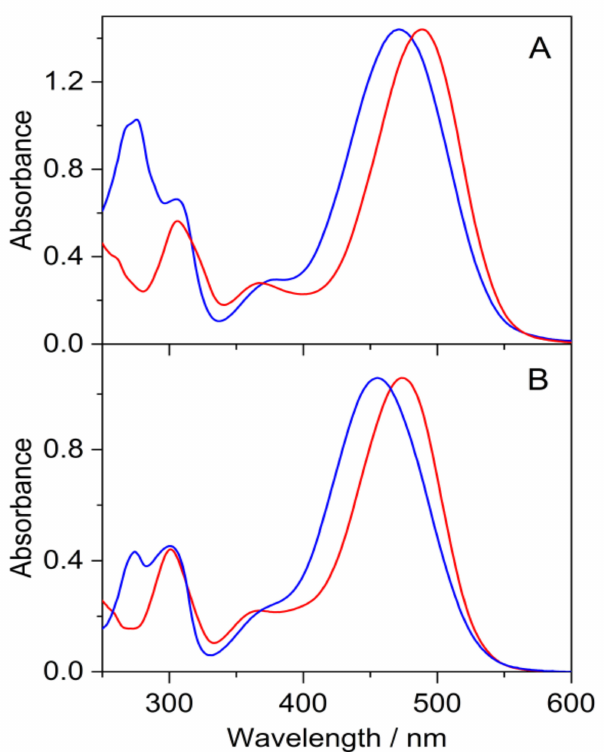
Figure 7. Absorption spectra of 5 (red line) and 7 (blue line) in methanol ( A ) and 0.01 M HCl aqueous solution ( B